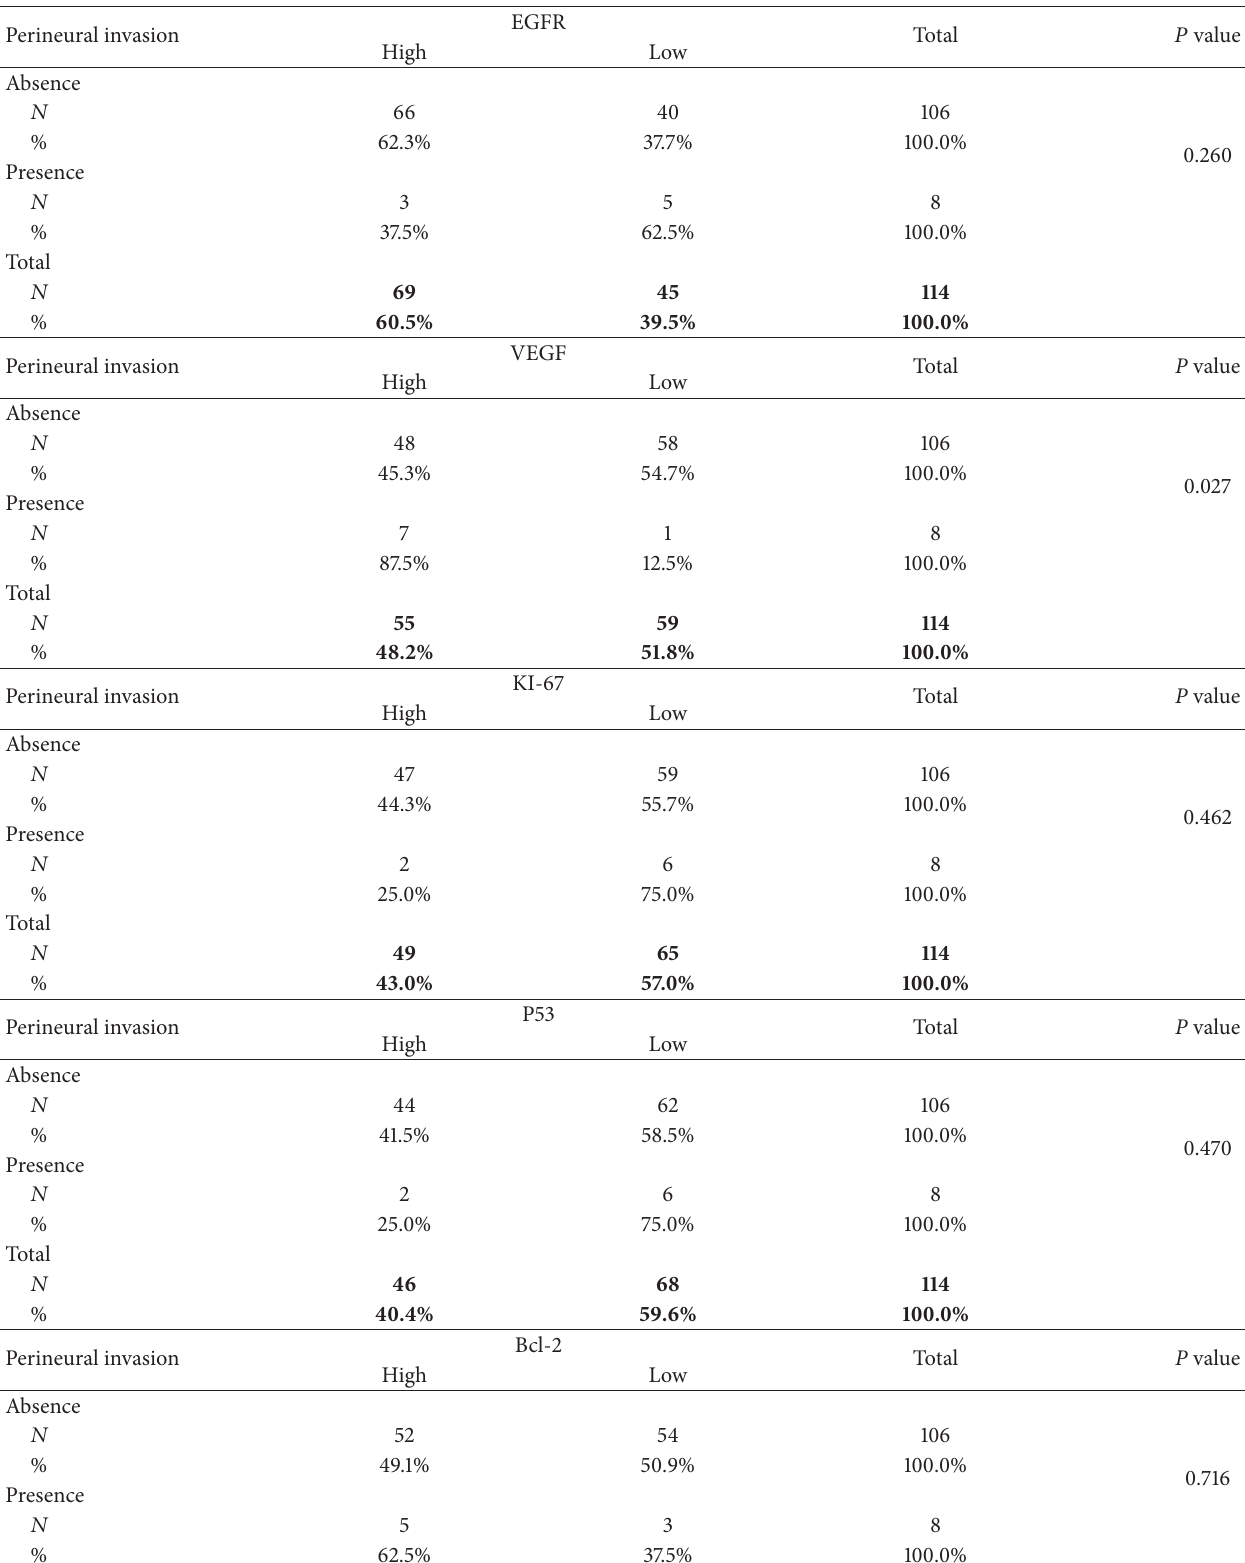
Table 7: The distribution of expression levels per IHC of proteins corresponding to ITGB-5, ITGA-3, MMP-2, MMP-9, and FN-1 ECM genes and EGFR, VEGF, Ki-67, P53, and Bcl-2 molecules as per the presence of perineural invasion in CRC ( 𝑛 = 114